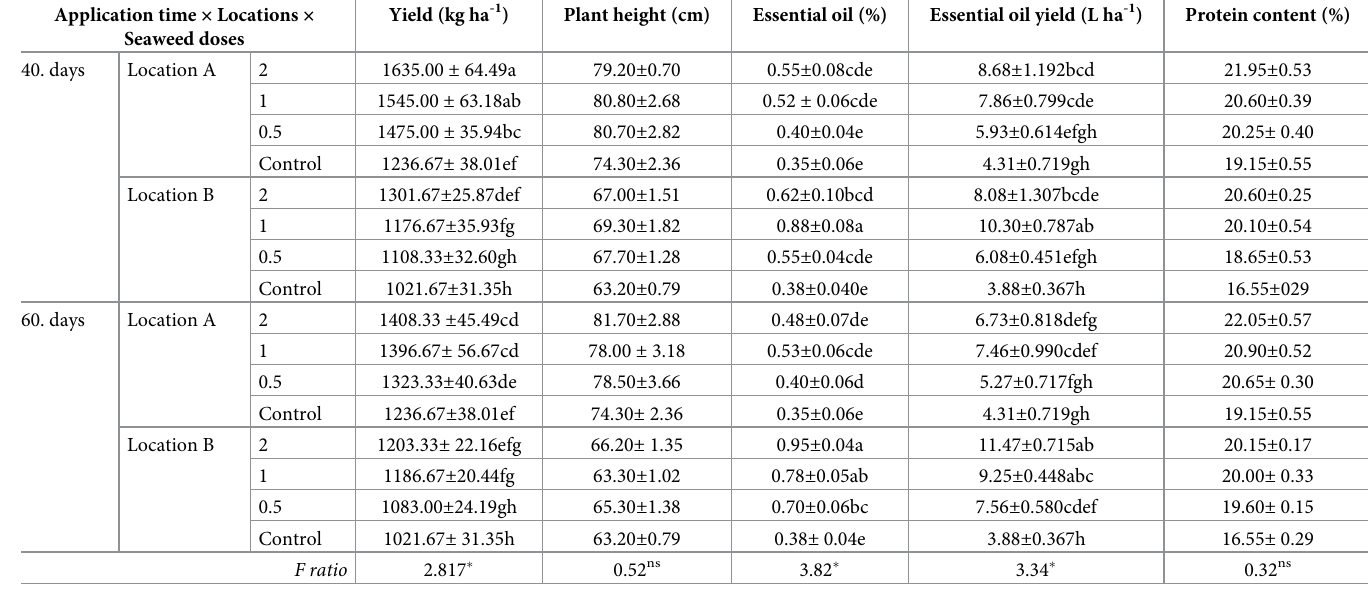
� p < 0.05 (significant); ns, non-significant. The difference between the averages represented with the same letter in the same column and same group was statistically